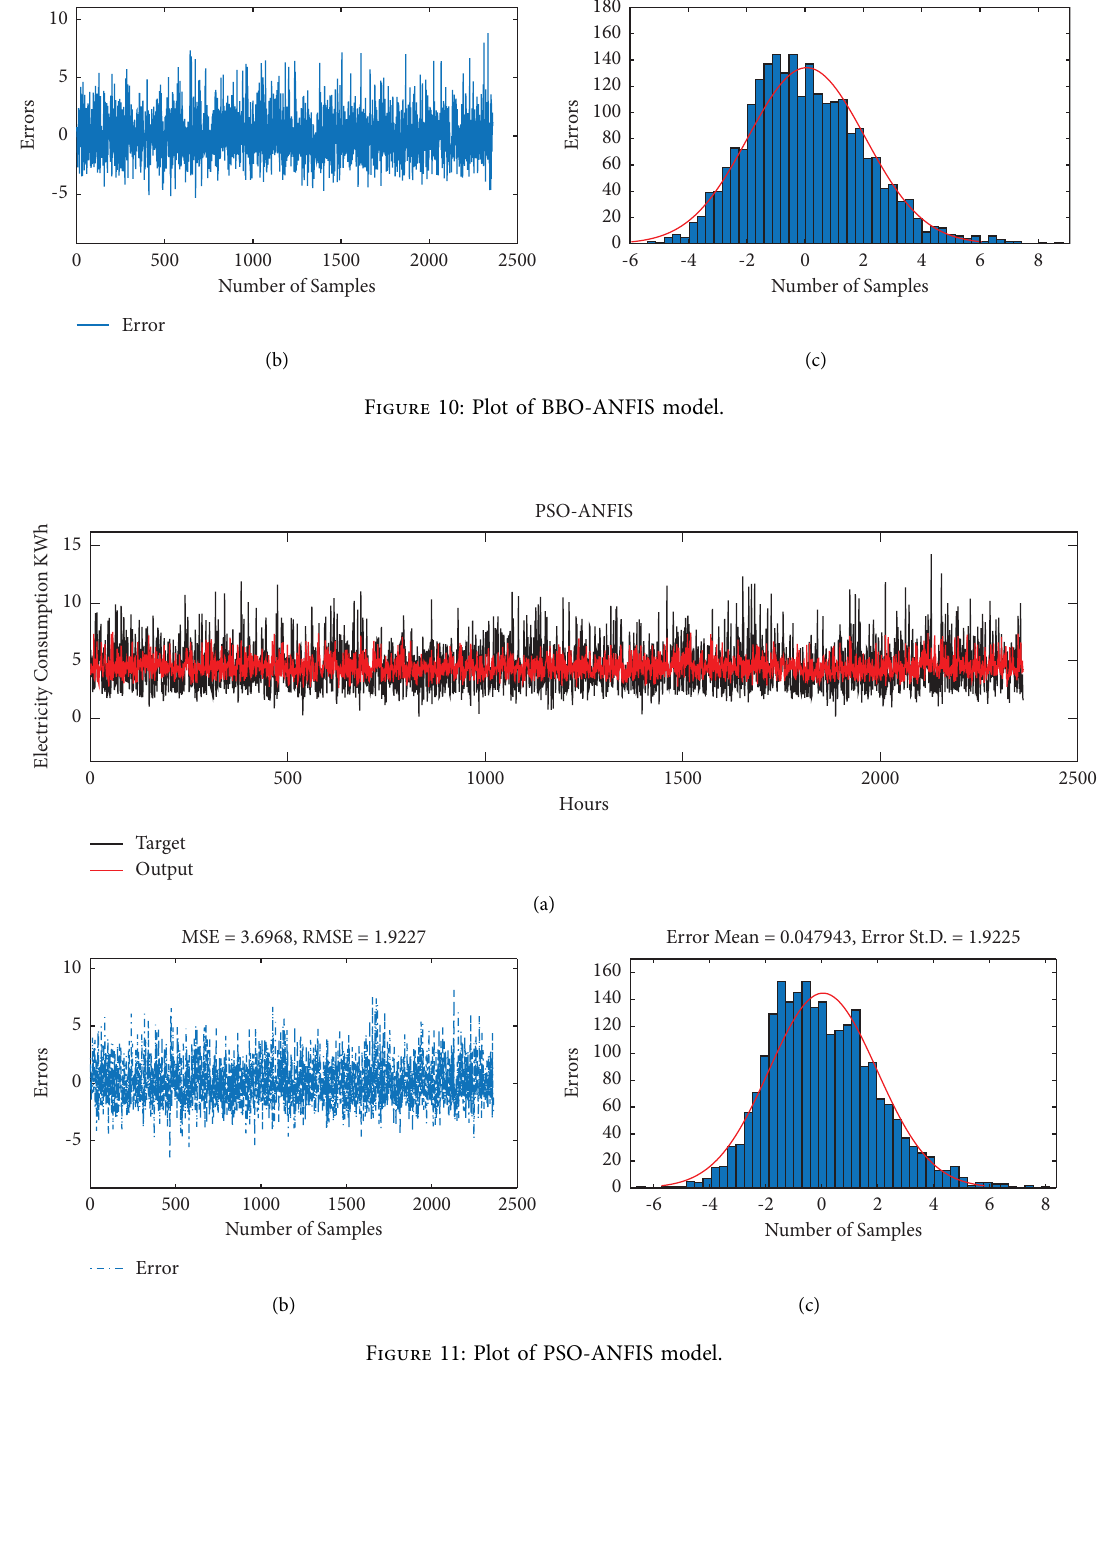
Figure 11: Plot of PSO-ANFIS